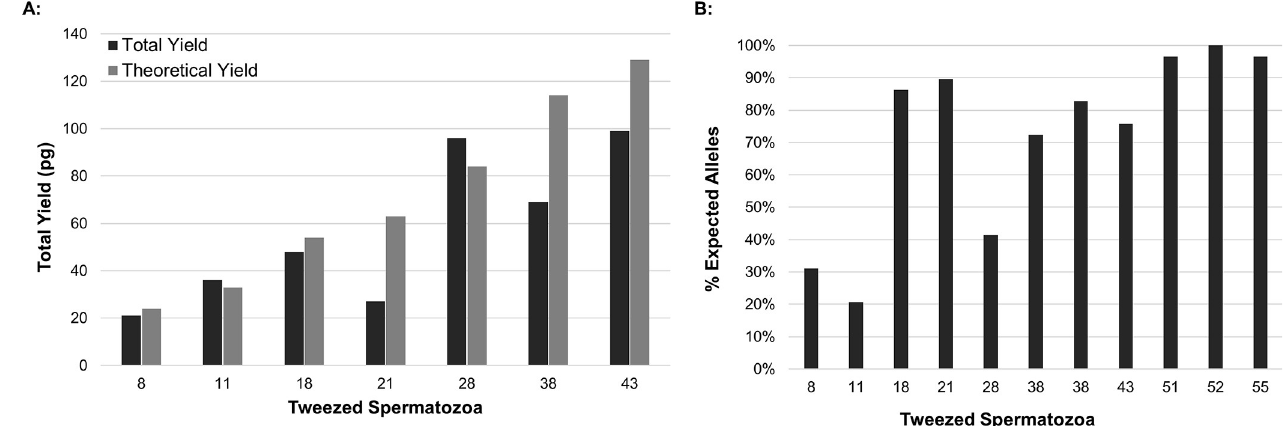
Fig 2. Total DNA Yields (A) and Percentage of Expected STR Alleles Detected (B) by sperm cell number tweezed. Cells were tweezed from semen samples. Each bar indicates a single sample.